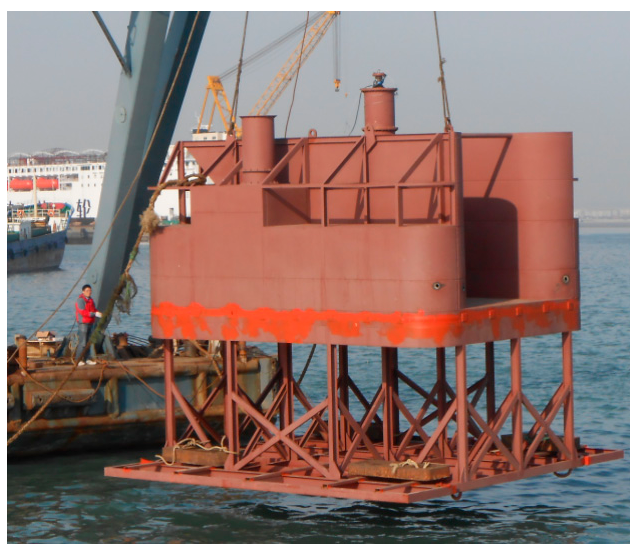
Figure 2. Engineering prototype.